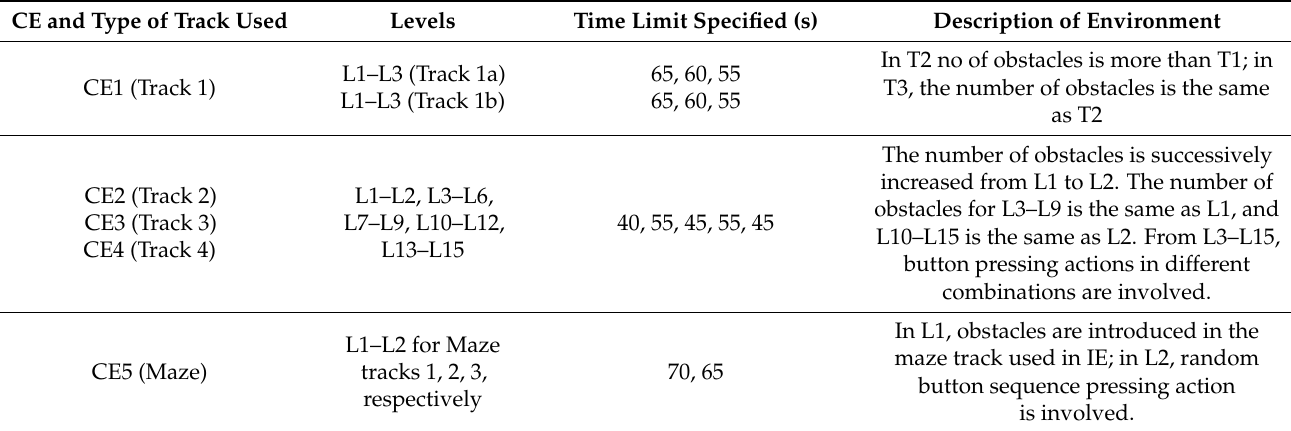
Table 3. Description of task difficulty levels in